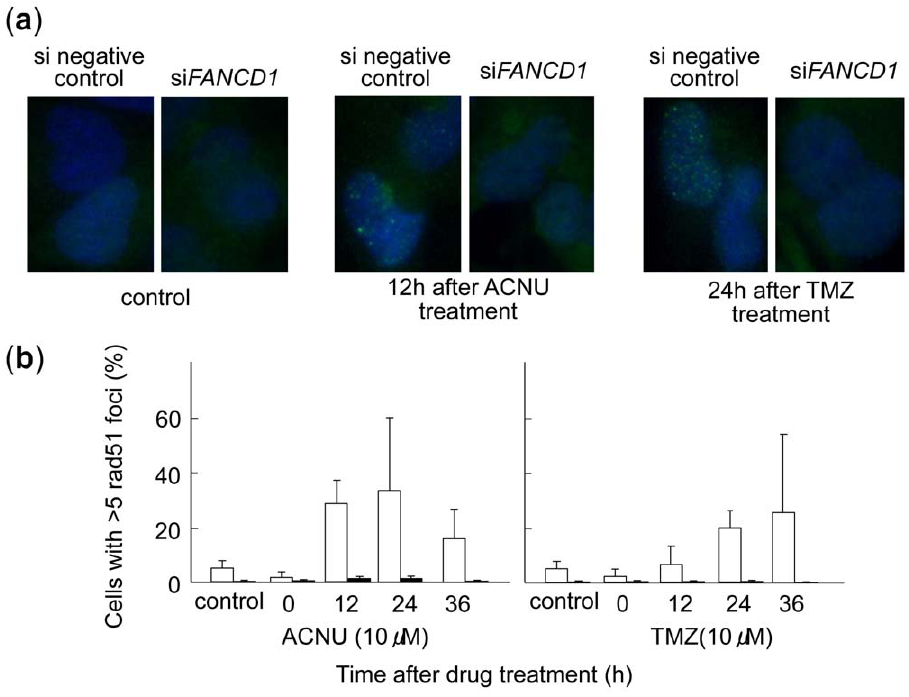
Figure 6. Rad51 foci formation in glioblastoma A172 cells after ACNU and TMZ treatments. a , typical photo. b , open columns, negative control siRNA; closed columns, FANCD1/BRCA2 siRNA. Columns show the mean of two independent experiments; bars indicate the SD.